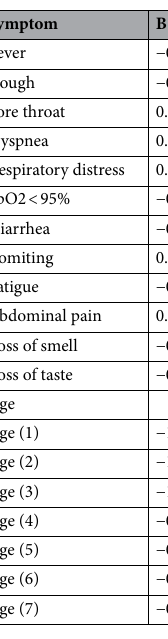
Table 4. Cox Regression Analysis (ICU).